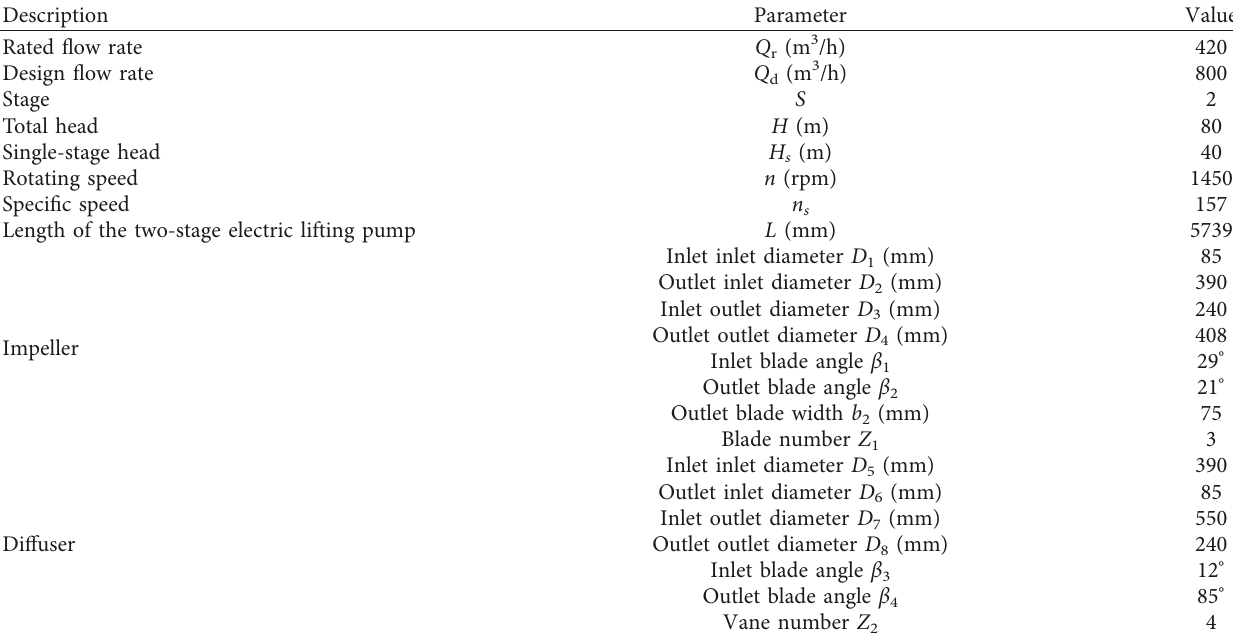
Table 1: Main specifications and geometric parameters.